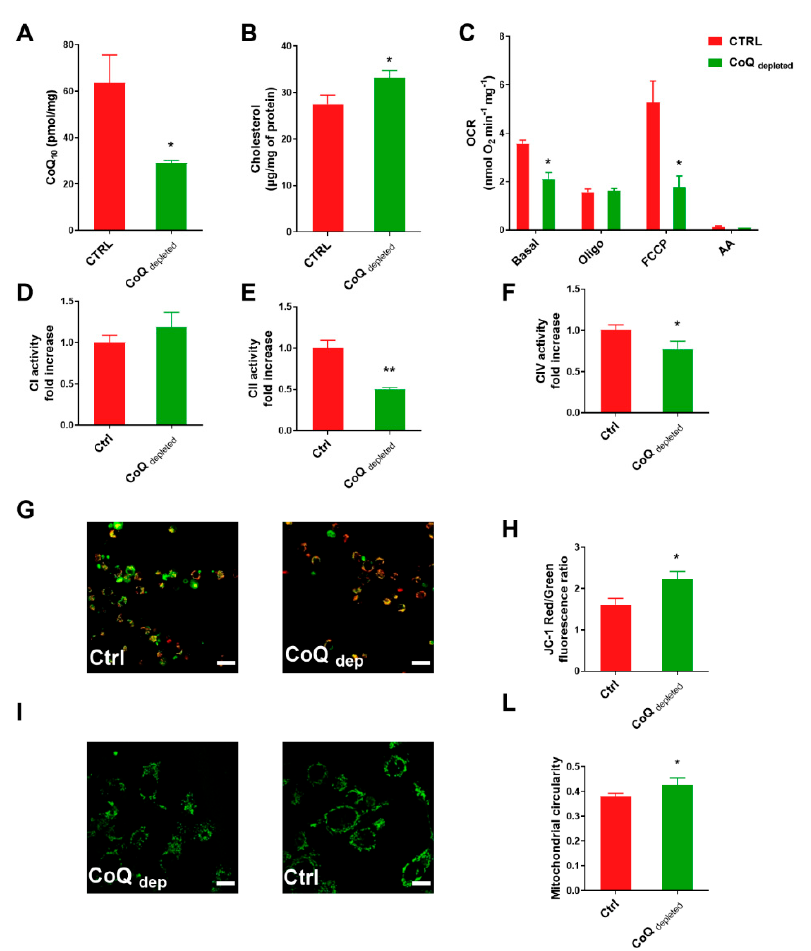
Figure 1. CoQ depletion induces mitochondrial dysfunction . MCF-7 cells were cultured in complete DMEM for 96 h in the presence of 4 mM 4-nitrobenzoic acid (CoQ depleted) or vehicle (CTRL). ( A ) Total ubiquinone determination in control and CoQ depleted MCF-7 cells normalized on protein content, ( n = 3). ( B ) Total cholesterol content in cell lysate from control and CoQ depleted cells normalized on protein content. ( C ) Oxygen consumption rate (OCR) in intact cells measured in DMEM (basal respiration), in the presence of oligomycin A (Oligo) and carbonyl cyanide 4 ‐ (trifluoromethoxy) phenylhydrazone (FCCP). To inhibit the mitochondrial respiration, 2 μ M Antimycin A was added at the end of each ex ‐ periment. ( n = 4). Electron transport chain complex I ( D ), II ( E ), and IV ( F ) enzyme activities were assessed in lysates from control and CoQ depleted cells. Results are displayed as fold increase ( n = 3). ( G ) Representative micrographs and their quantification ( H ) of control and CoQ depleted cells stained with JC ‐ 1 dye, a cationic dye (green) which exhibits potential ‐